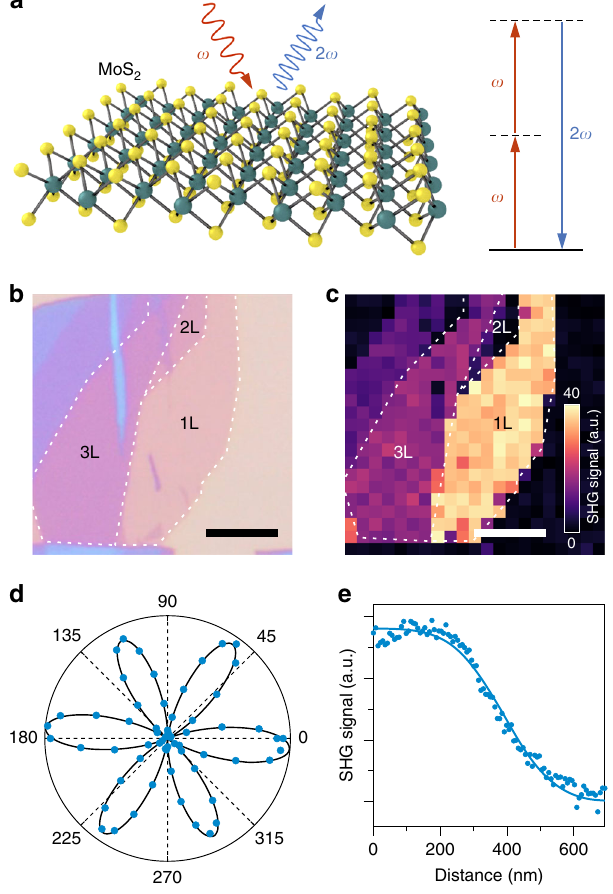
Fig. 1 Second harmonic generation in MoS 2 . a Schematic illustration of the SHG process. b Micrograph of a mechanically exfoliated MoS 2 fl ake on a Si/SiO 2 wafer, and c corresponding SHG amplitude. Note that the SHG signal is absent in the bilayer region. Scale bars, 5 μ m. d Linear polarization dependence of the SHG intensity from an MoS 2 monolayer. e SHG line scan across an MoS 2 edge. Symbols: experimental data. Line: fi t of a function of ffiffiffi p (cid:3) (cid:4) x = w the form 1 (cid:2) erf 2 , where erf() is the error function and w is the waist, from which a spatial resolution of 280 nm (FWHM) is